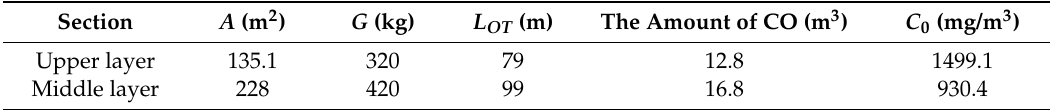
Table 2. The initial concentration of CO after cavern blasting.